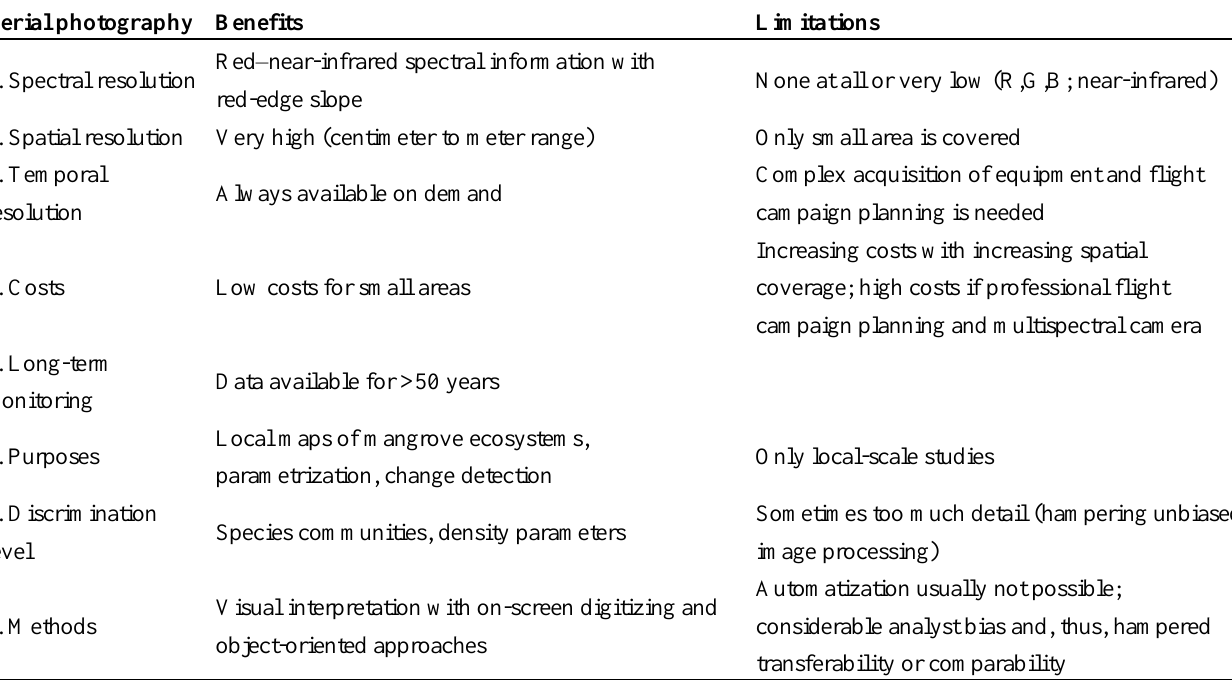
Table 3. Benefits and limitations of aerial photography for mangrove